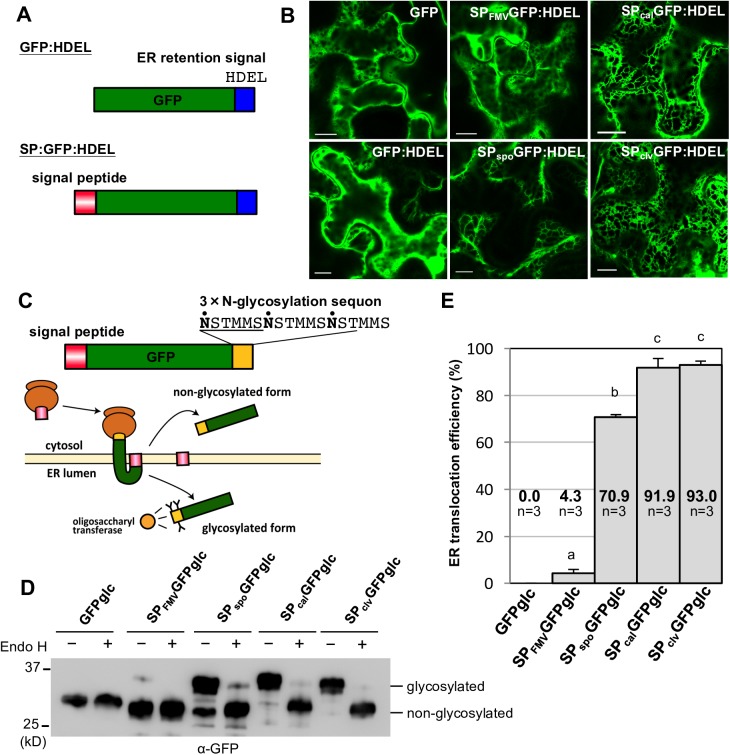
ER translocation efficiency of SPFMV differs from those of plant protein SPs.(A) Schematic representation of fusion proteins for investigating ER translocation efficiency. (B) Cells expressing free GFP, GFP:HDEL, SPFMVGFP:HDEL, SPspoGFP:HDEL, SPcalGFP:HDEL and SPclvGFP:HDEL were observed at 36 hpi. Bars = 10 μm. (C) Schematic representation of the experimental system and fusion proteins with a 3×N-glycosylation sequon. Dots indicate asparagine residues expected to be glycosylated. SPs of MPFMV, sporamin A, calreticulin or CLAVATA3 were fused to the N terminus of GFP:glc, GFP carrying a 3×N-glycosylation sequon in its C terminus (SPFMVGFPglc, SPspoGFPglc, SPcalGFPglc and SPclvGFPglc, respectively). (D) Immunoblot analysis of proteins extracted from cells expressing GFPglc, SPFMVGFPglc, SPspoGFPglc, SPcalGFPglc or SPclvGFPglc using anti-GFP antibody. Samples were collected at 30 hpi. Glycosylation of each sample was confirmed by deglycosylation with Endo H. (E) Quantitation of translocation efficiencies. The bars show means + SD of three independent experiments. Different letters on the error bars indicate statistical differences at the 1% level of significance (Tukey test).